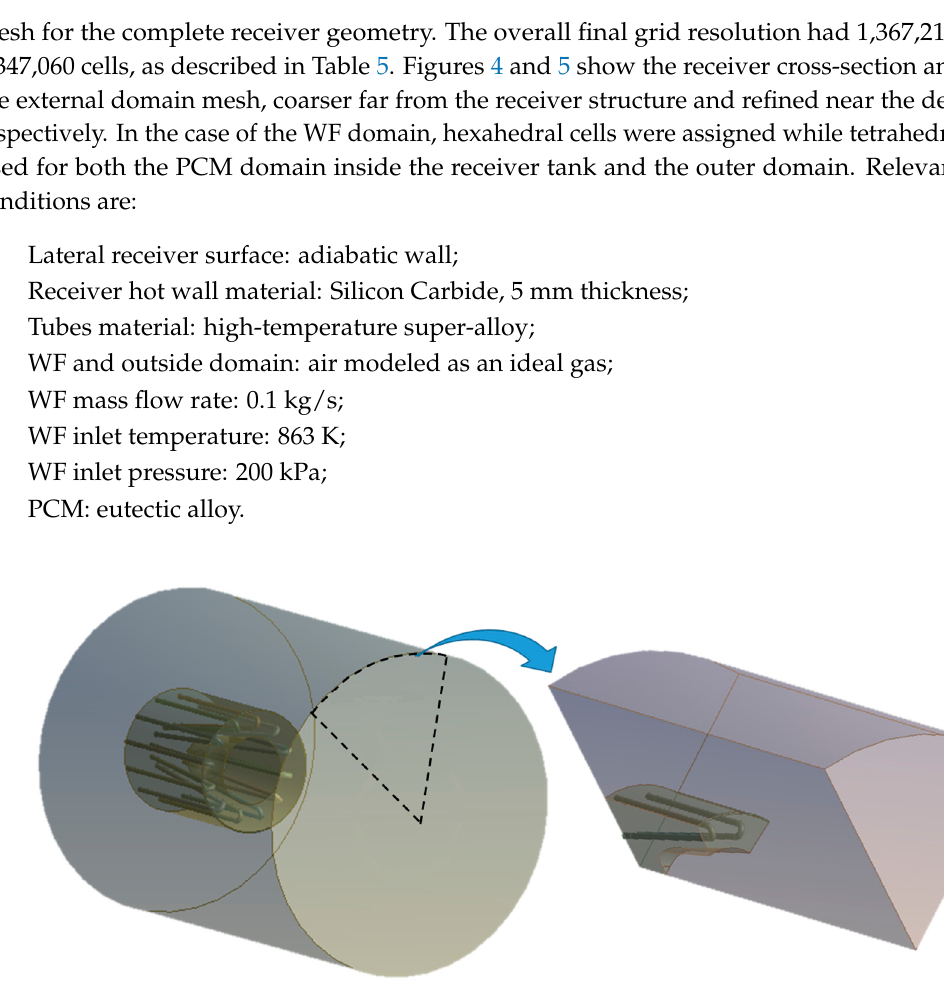
Figure 3. Scheme of the overall computational domain ( Left ) and details of the section used for the grid independency analysis ( Right ). Table 4. Mesh independency analysis conducted on 1/6 of the overall domain.